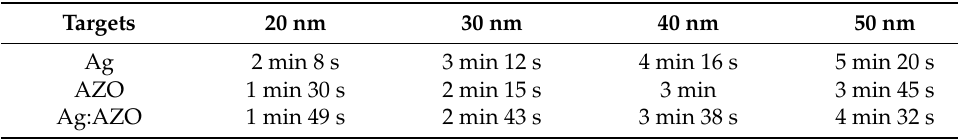
Table 2. Deposition rate of each electrode by thickness.